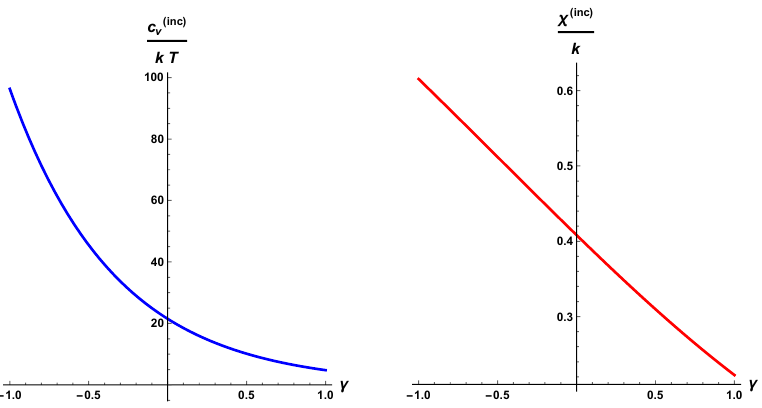
Figure 1 . Heat capacity and charge susceptibility in the incoherent limit in function of the Horn- deski coupling (cid:13)